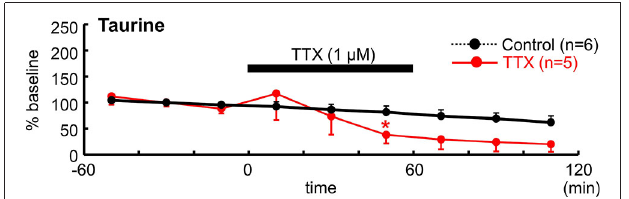
FIGURE 5 | TTX reduced ambient taurine levels . Temporal changes in extracellular taurine concentrations after bath application of 1 µ M TTX for 60 min during microdialysis were estimated and are indicated as % baseline value. TTX was applied as indicated. The baseline value was defined as the average value 60 min immediately before TTX application and the control data are from Figure 4D . * P < 0.05 as compared with control (Mann–Whitney U -test).